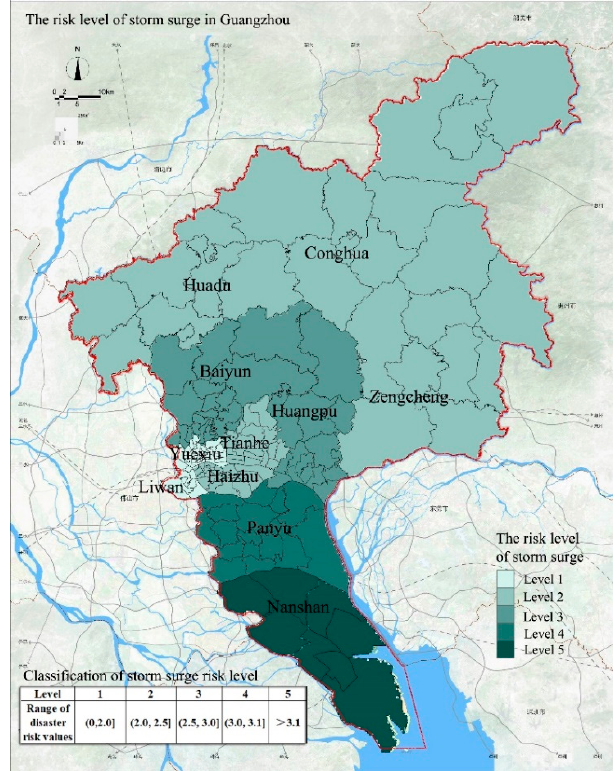
Figure 3. The risk levels of storm surge in Guangzhou.